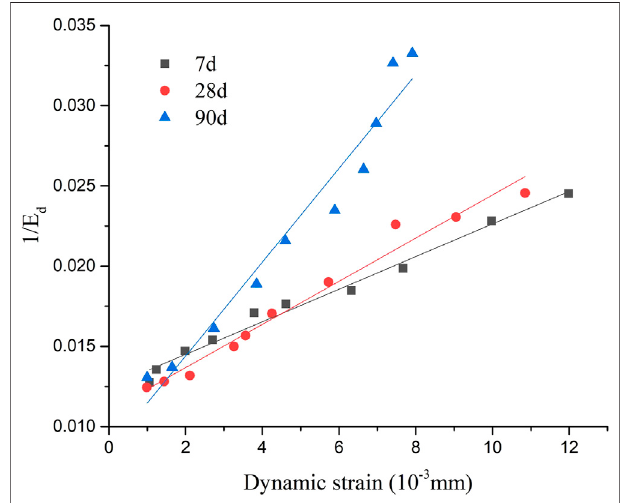
FIGURE 6 | Relationship curve of 1/E d ∼ ε d of solidi fi ed muddy soil at different curing ages.